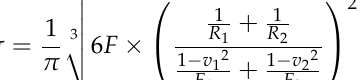
Figure 2. ( a ) Surface roughness and ( b )